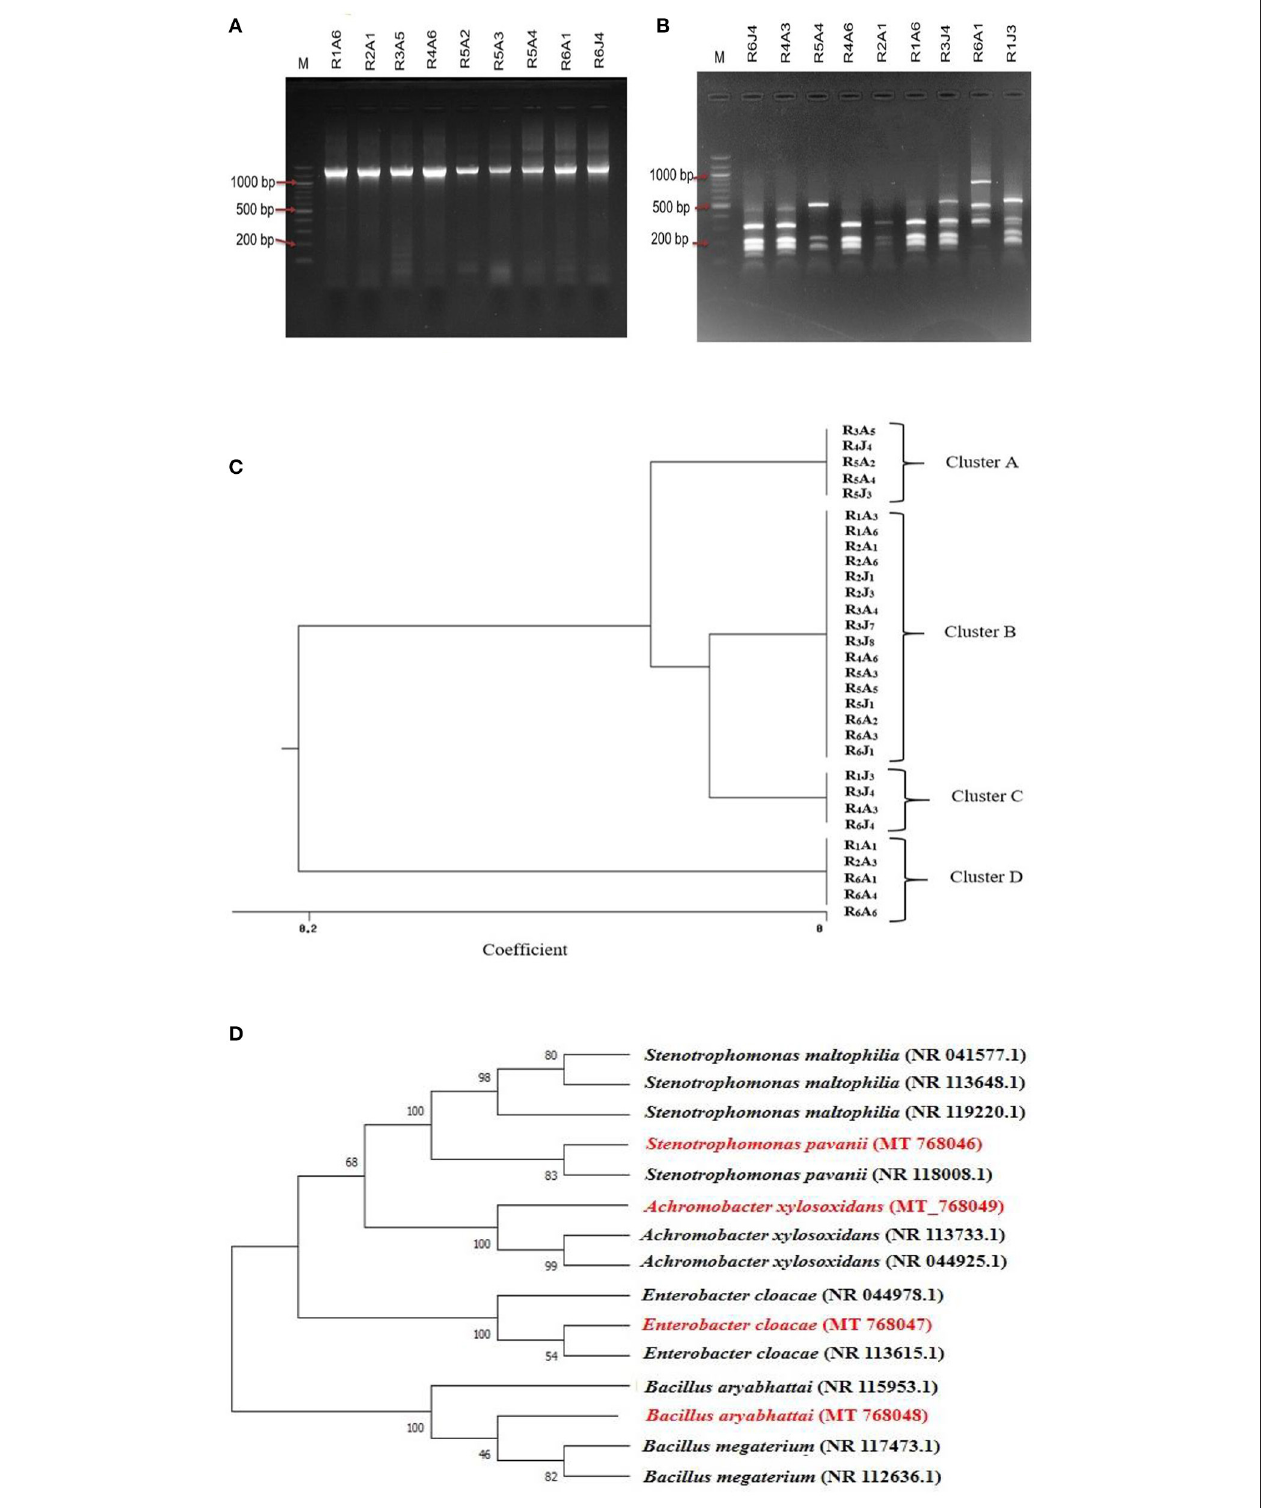
FIGURE 3 | A representative illustration of 16S rDNA products amplified from the respective bacterial genome by PCR and electrophoresed on a 1.5% agarose gel (A) and ARDRA analysis of the 16S rDNA amplicon digested with the Bsu RI ( Hae III) enzyme in a 1.5% (w/v) agarose gel; M: 100 bp ladder (B) , and the resulting restriction pattern was used to produce a Dendrogram (C) . The phylogenetic tree shows evolutionary distance among isolates based on 16S rDNA gene sequence using MEGA X. Bootstrap values are represented by numbers at the nodes based on 1,000 replications. The scale is the evolutionary distance value (D) .